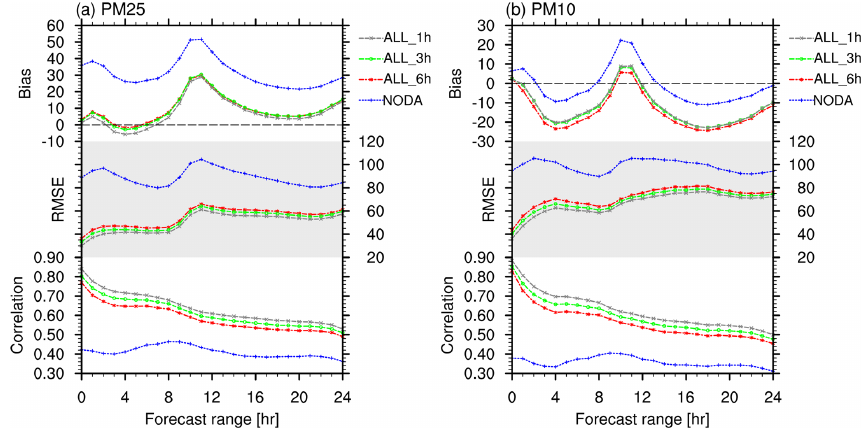
Figure 10. Averaged bias (units: µgm − 3 ), RMSE (units: µgm − 3 ), and correlation for (a) PM 2 . 5 and (b) PM 10 in different experiments as a function of forecast range, verified against the surface observations of 531 stations in China. The blue, red, green, and gray lines denote the results of experiment NODA, ALL_6h, ALL_3h, and ALL_1h,